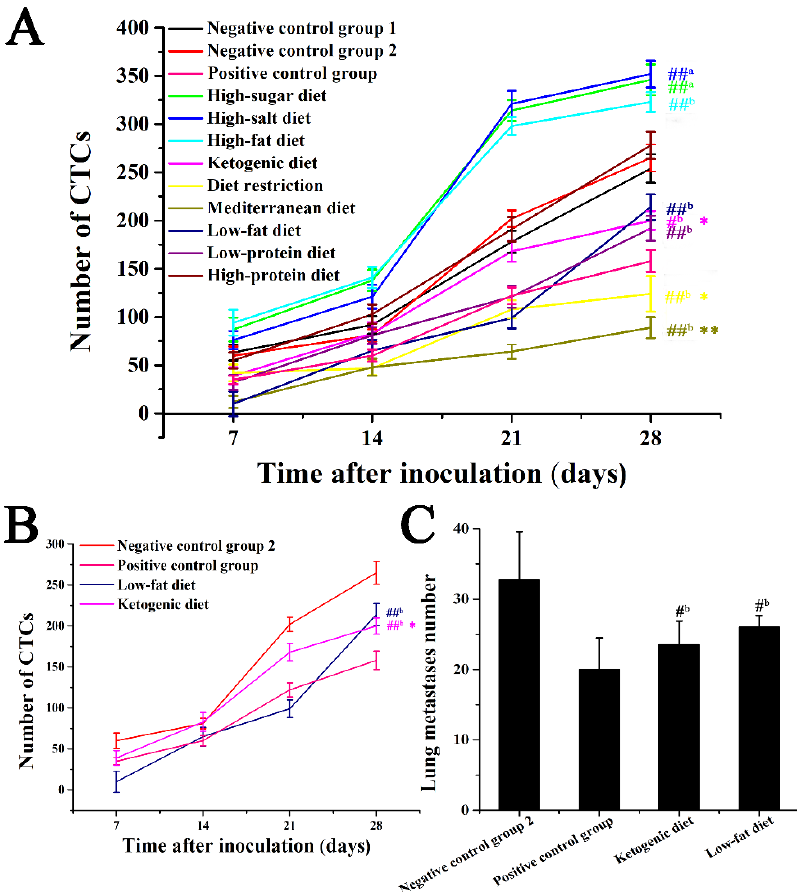
Figure 5. Effect of different dietary patterns on CTC numbers. ( A ) CTC numbers of different dietary patterns during cancer progression. ( B ) CTC numbers of Mediterranean diet group and high-salt diet group during cancer progression. ( C ) Numbers of lung metastatic cancers of Mediterranean diet group and high-salt diet group during cancer progression. ##a p < 0.01 compared with that of negative control group 1. #b p < 0.05 and ##b p < 0.01 compared with that of negative control group 2. * p < 0.05 and ** p < 0.01 compared with that of positive control group.